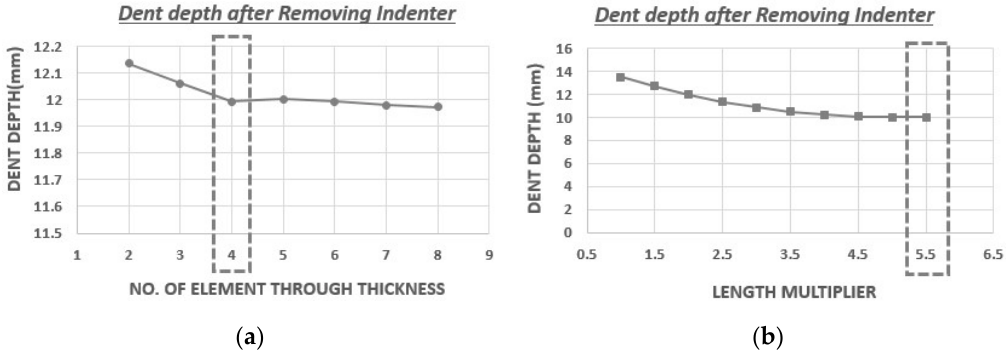
Figure 3. Convergence study results: (a) the mesh size, (b) model length.